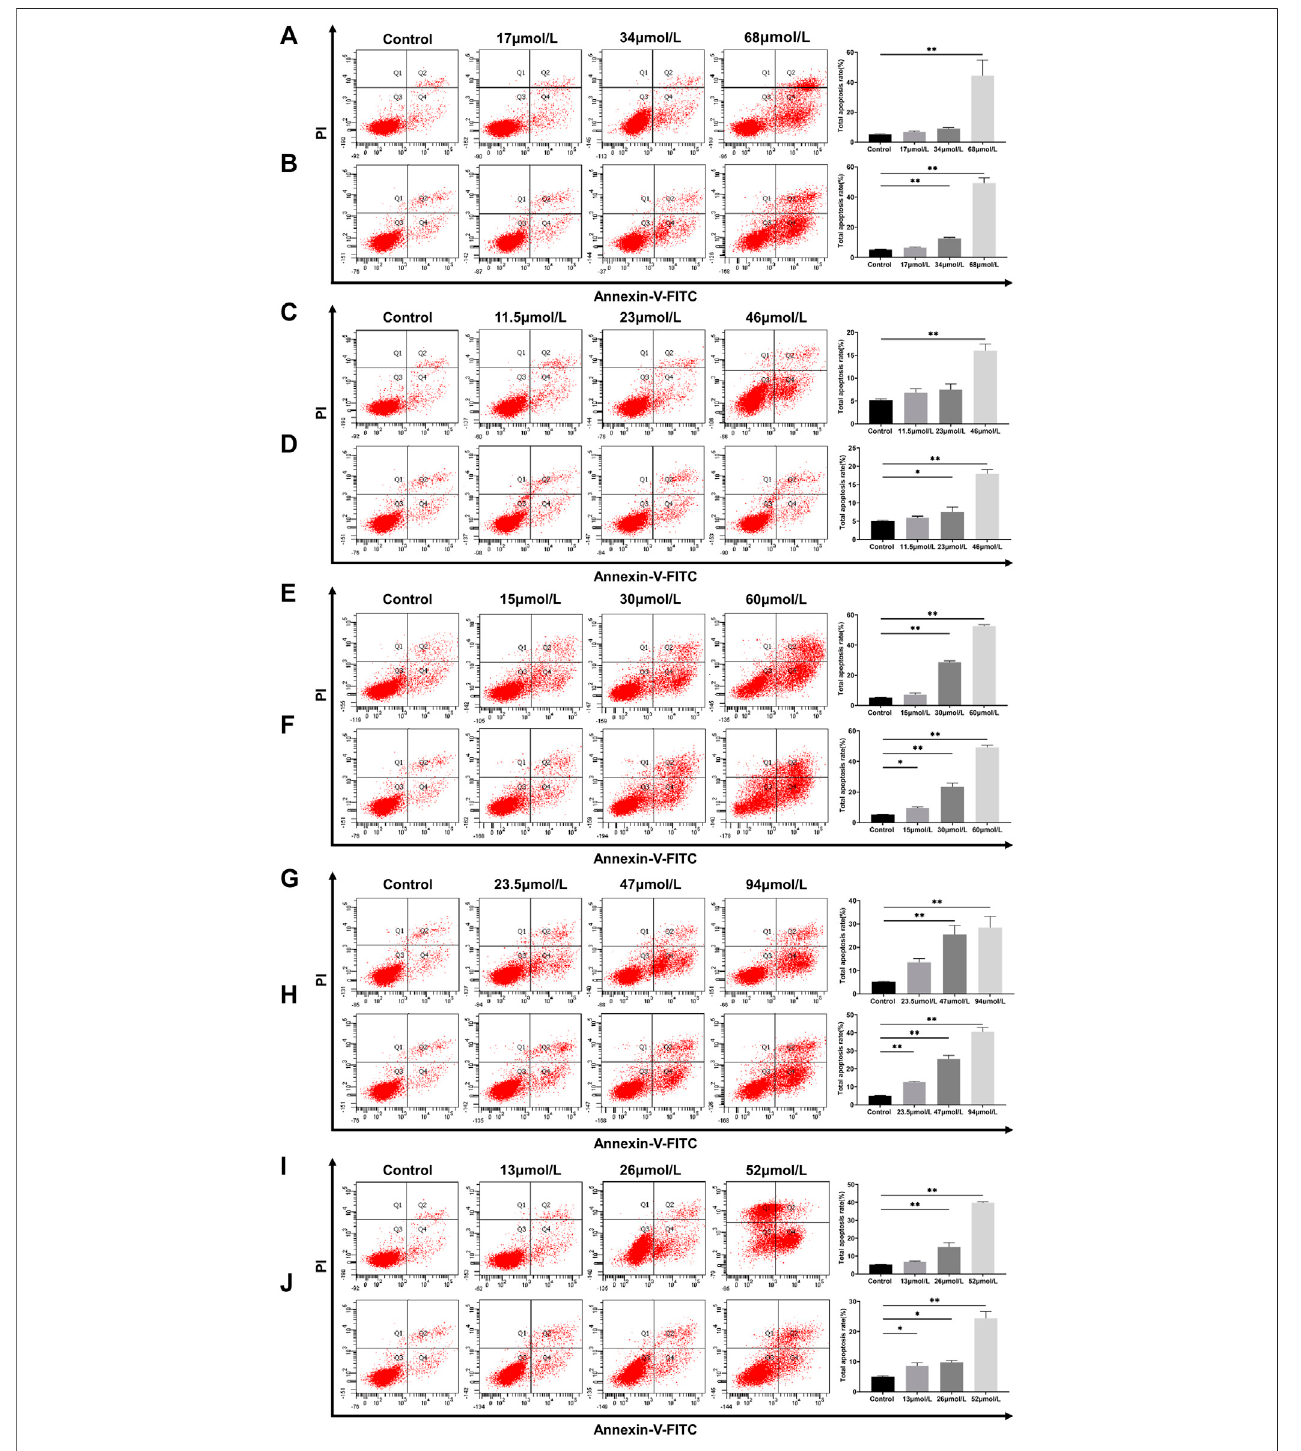
FIGURE7| ApoptosisofL02andHepG2cellstreatedwithbavachin (A,B) ,psoralidin (C,D) ,bavachinin (E,F) ,neobavaiso fl avone (G,H) ,andbakuchiol (I,J) .These values are presented as mean ± SD and n (cid:1) 3. * p < 0.05, ** p < 0.01 versus the control group.